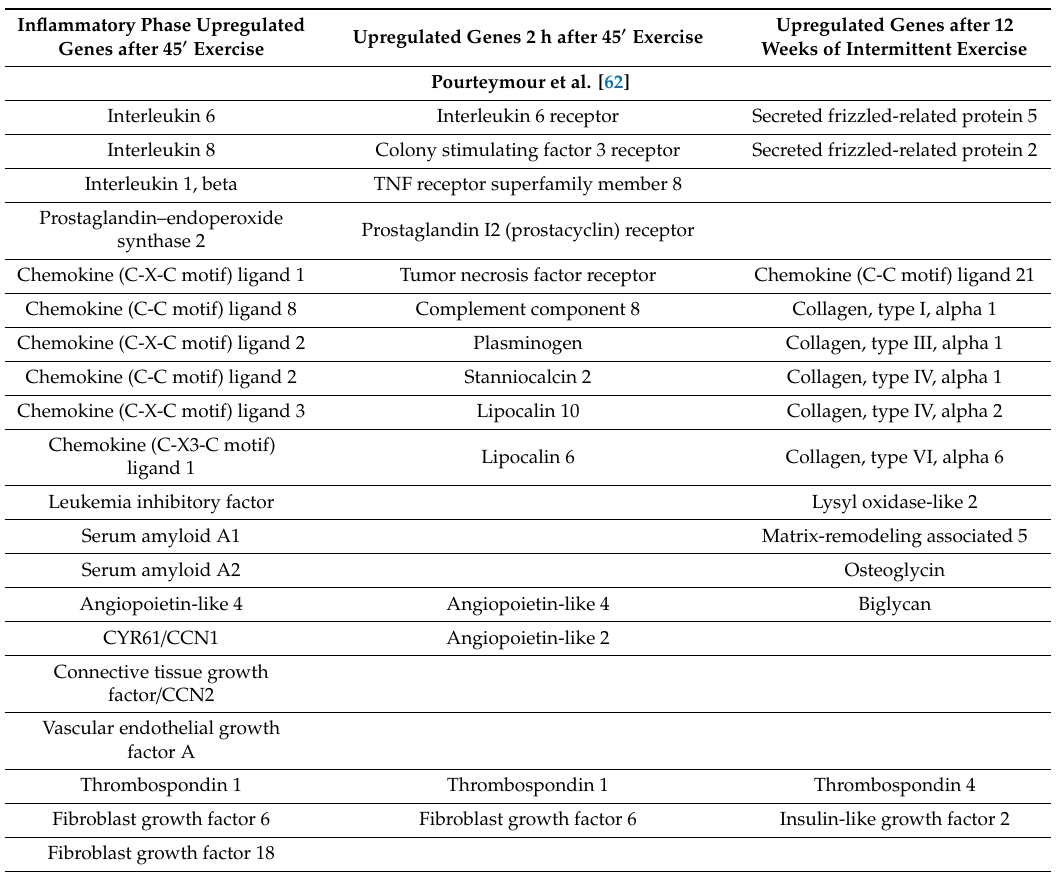
Table 1. Exercise-related upregulation of genes in muscle biopsies after 45 min exercise, 2 h after 45 min exercise, and 12 weeks after intermittent exercise according to Pourteymour et al. [62]. Many of these genes have putative functions in bone regeneration (see also text). Virtually all genes of the inflammatory phase have implications in the early phase of skeletal stem cell commitment and bone regeneration; also, genes active in neoangiogenesis are relevant for bone healing, regeneration, and remodeling [82,91,96,97]. Abbreviations: CYR61 / CCN1: cysteine-rich angiogenic inducer 61, TNF: tumor necrosis factor. Inflammatory Phase Upregulated Upregulated Genes 2 h after 45 (cid:48) Genes after 45 (cid:48) Exercise